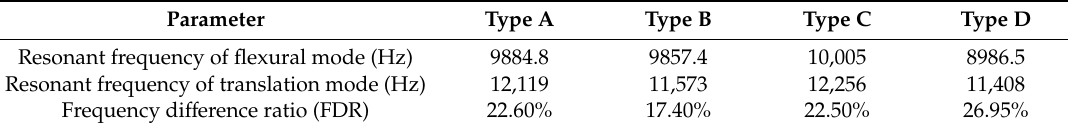
Table 4. Natural frequencies of the flexural and translation modes and the FDR of all types.